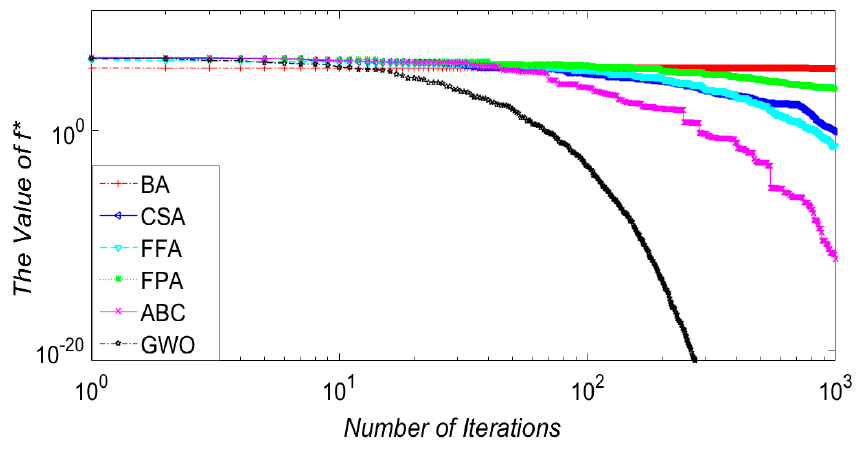
Figure 3. Convergence speed for Griewank ( f 7 ) function (30D).